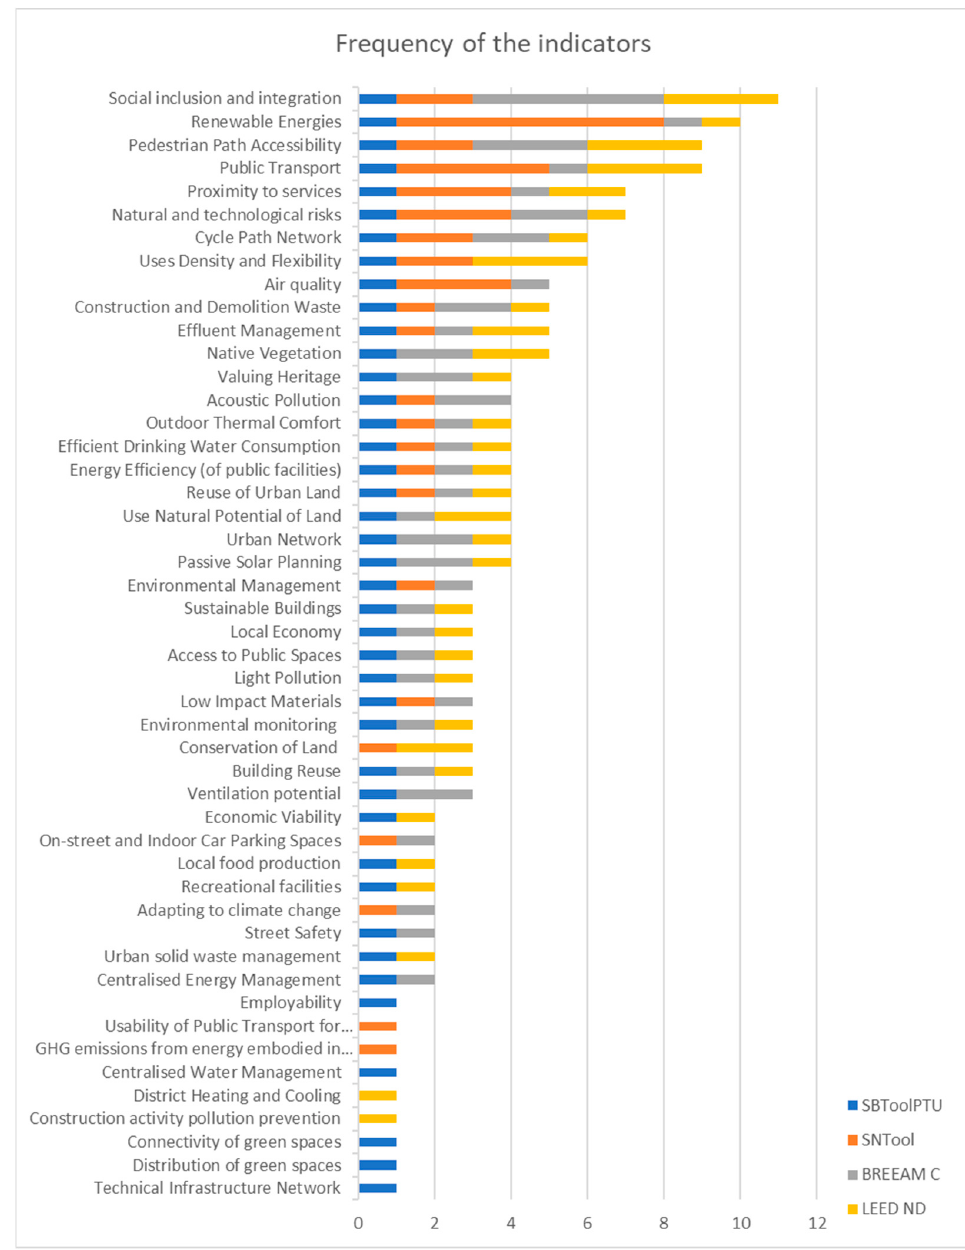
Figure 1. The frequency of use of the indicators among the selected sustainability assessment